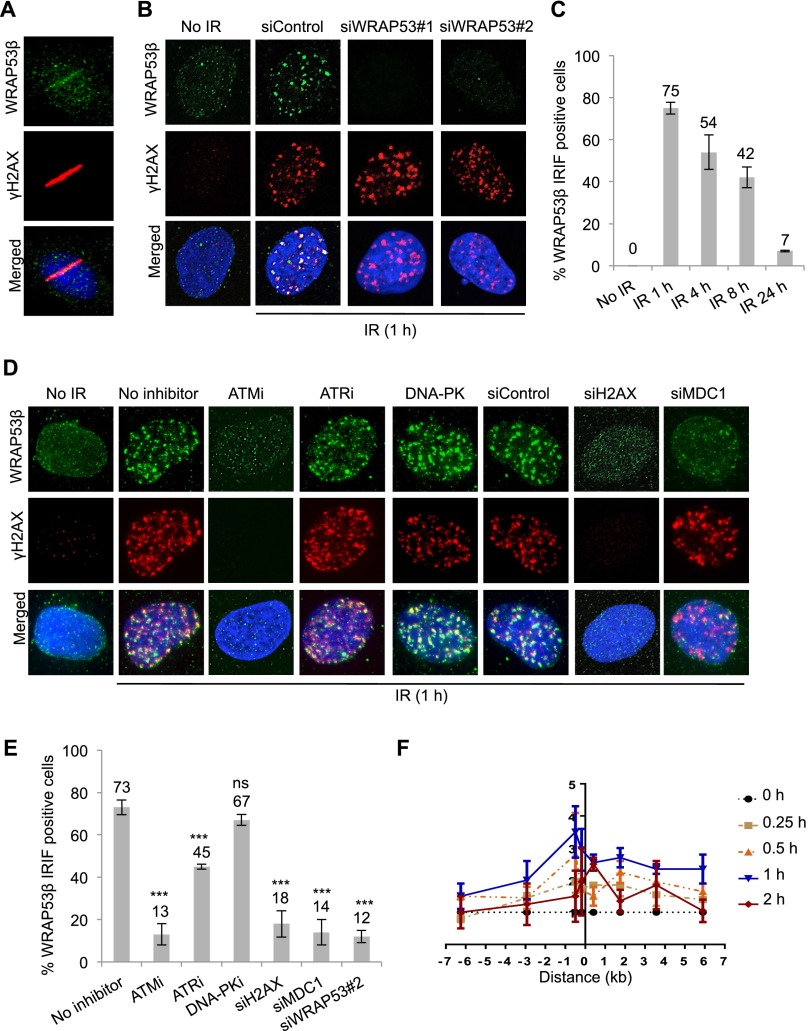
WRAP53β accumulates at sites of DNA damage in an ATM/H2AX/MDC1-dependent manner. (A) U2OS cells were microirradiated, fixed 5 min later, and immunostained for WRAP53β and γH2AX, a marker for DNA DSBs. Nuclei were stained with DAPI in all immunofluorescence experiments. (B) U2OS cells were treated with siControl or two different WRAP53β targeting oligonucleotides (siWRAP53#1 and siWRAP53#2) for 48 h, irradiated (6 Gy, 1-h recovery) or left untreated, fixed after pre-extraction with cytoskeleton (CSK) buffer, and immunostained for WRAP53β and γH2AX. (C) U2OS cells were irradiated (6 Gy), fixed, and immunostained for WRAP53β at the indicated time points. Quantification is given as the percentage of the 100 cells counted in each experiment whose nuclei contained WRAP53β IRIF. (D) U2OS cells were treated with the inhibitors or siRNAs, as indicated, for 6 h or 48 h, respectively; irradiated (6 Gy, 1-h recovery); fixed after pre-extraction with CSK buffer; and immunostained for WRAP53β and γH2AX. (E) Quantification of the results in D, as the percentage of the 100 cells counted in each experiment whose nuclei contained WRAP53β IRIF. The error bars depict the SEM; n = 3; (***) P < 0.001 as determined by Student’s t-test. (F) ChIP assay showing the recruitment of WRAP53β to the I-PpoI-induced DSB at chromosome 1 in MCF7 cells stably expressing ddI-PpoI. The time indicated is hours after the addition of 4-OHT. The I-PpoI cleavage site on chromosome 1 is located at distance 0. Cells were cultivated in medium containing 0.1% FBS for 24 h before DSB induction. Data are shown as the mean of two independent experiments. The Y-axis displays the fold change in relative occupancy normalized to the control.